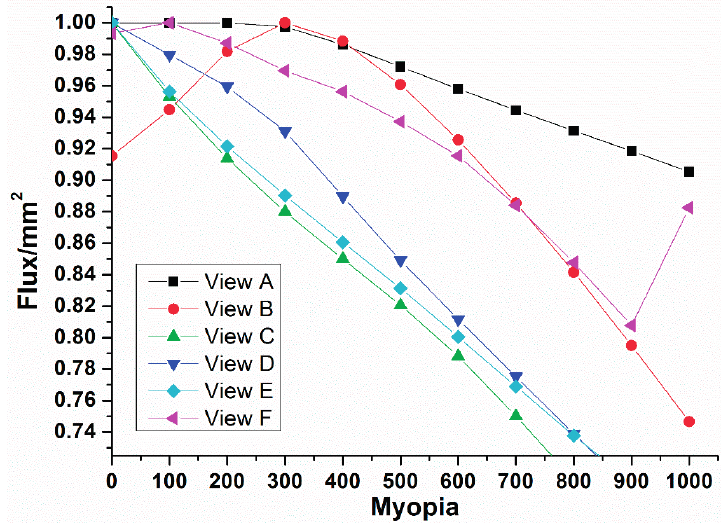
Figure 10. Effects of degrees of myopia on the changes in light flux in the visual region under different Snellen chart visual regions.